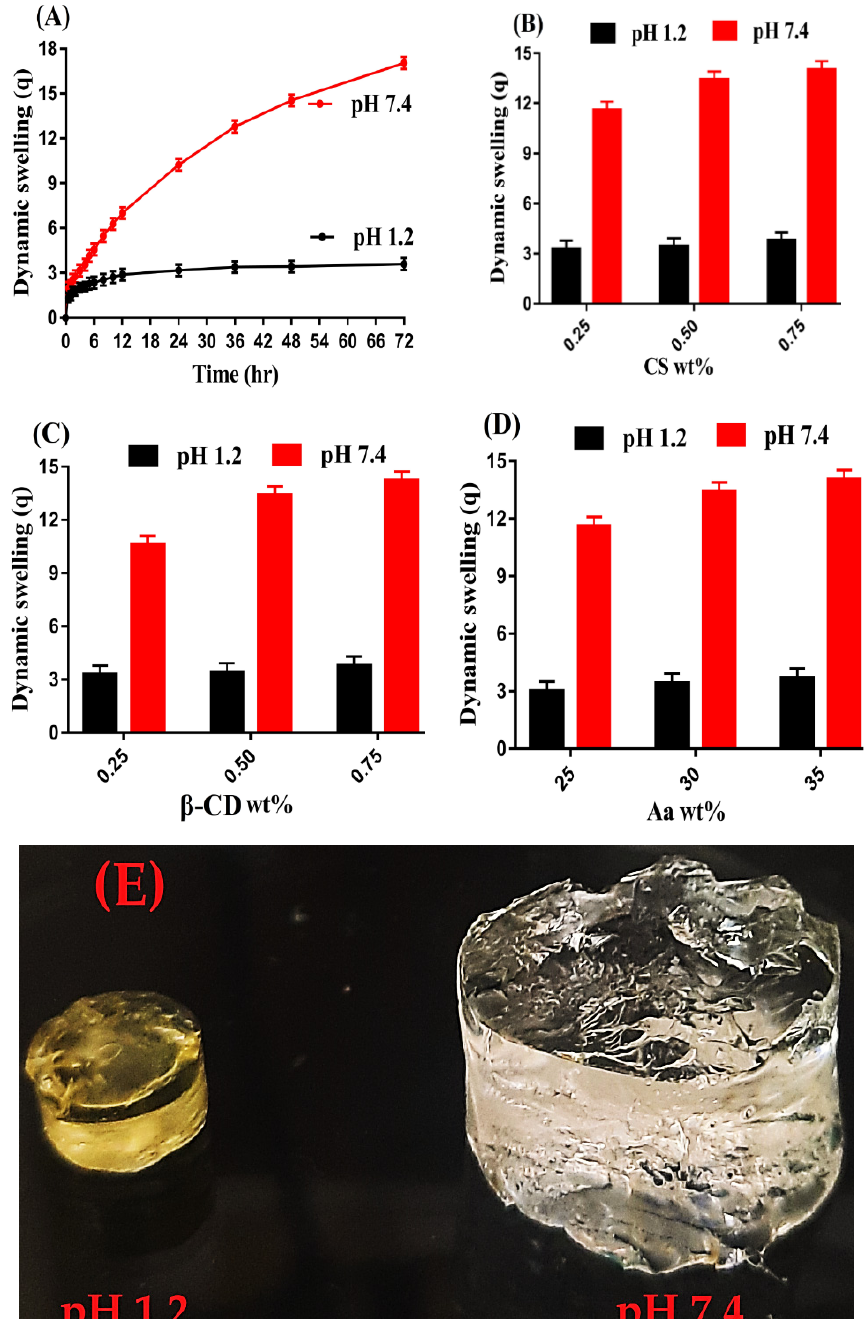
Figure 7. Effect of ( A ,) pH, ( B ) CS, ( C ) β -CD, and ( D ) Aa on dynamic swelling of CS/ β -CDcPAa hydrogel, ( E ) physical appearance of swelled CS/ β -CDcPAa hydrogel in pH 1.2 and 7.4.